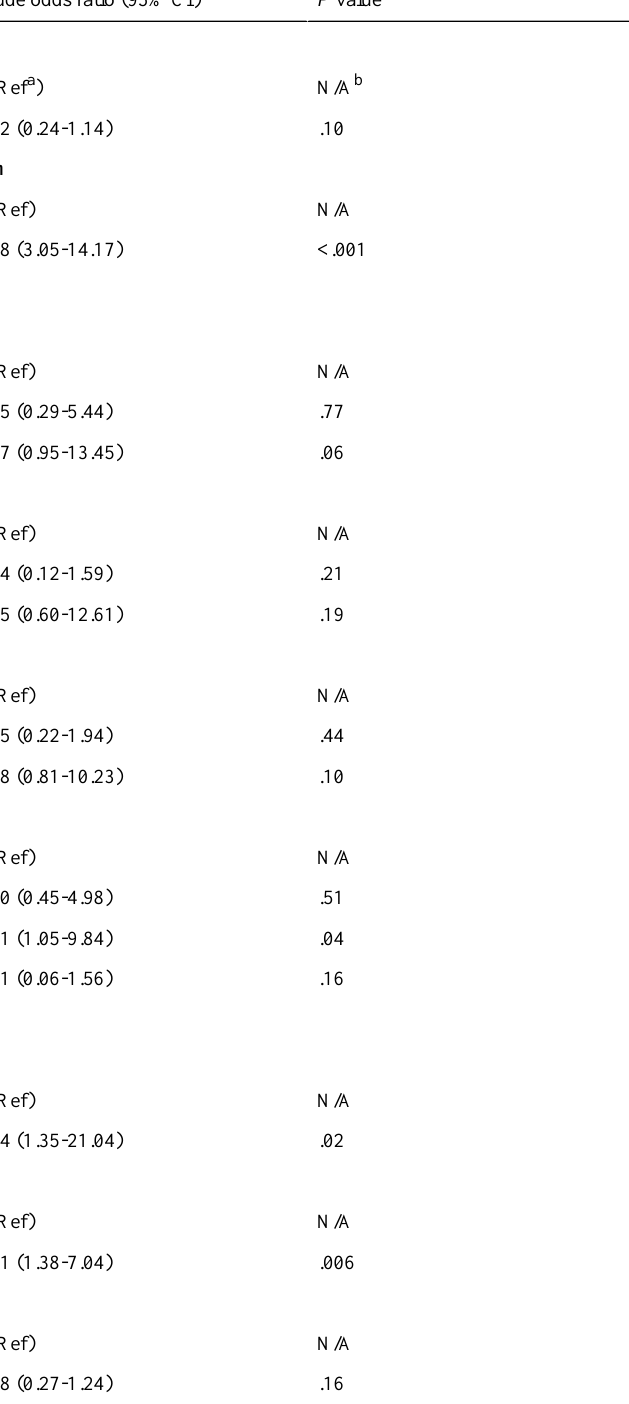
Table 5. Factors associated with the usage of system among